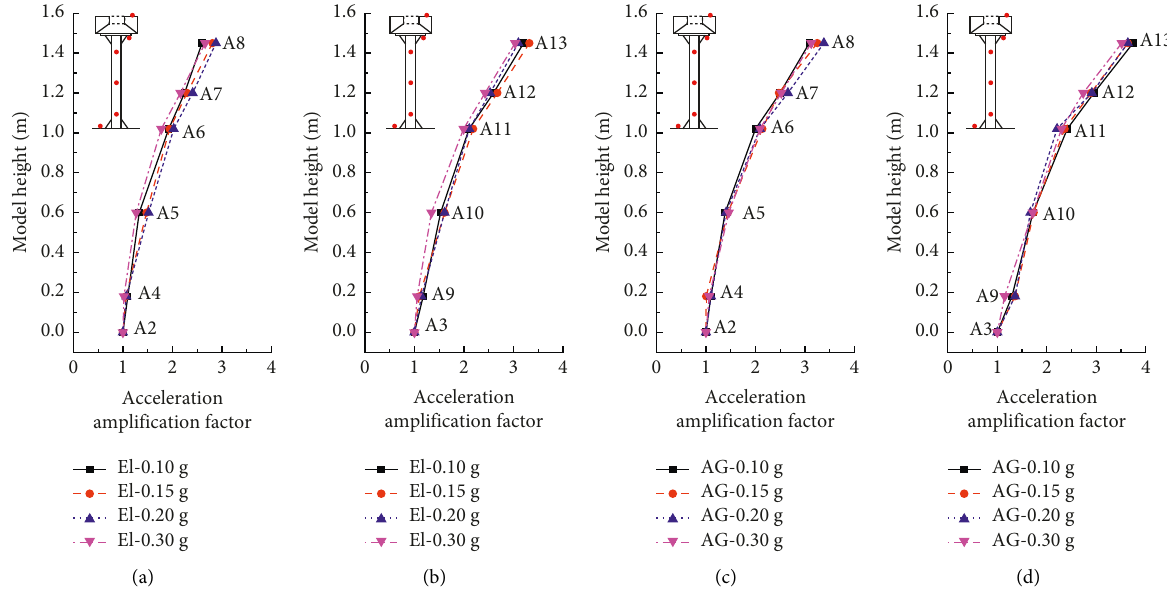
Figure 9: Acceleration amplification factor curves under different inputs. (a) El-M1. (b) El-M2. (c) AG-M1. (d) AG-M2 (El: scaled El Centro ground motion; AG: scaled artificial ground motion; M1: model I; and M2: model II).